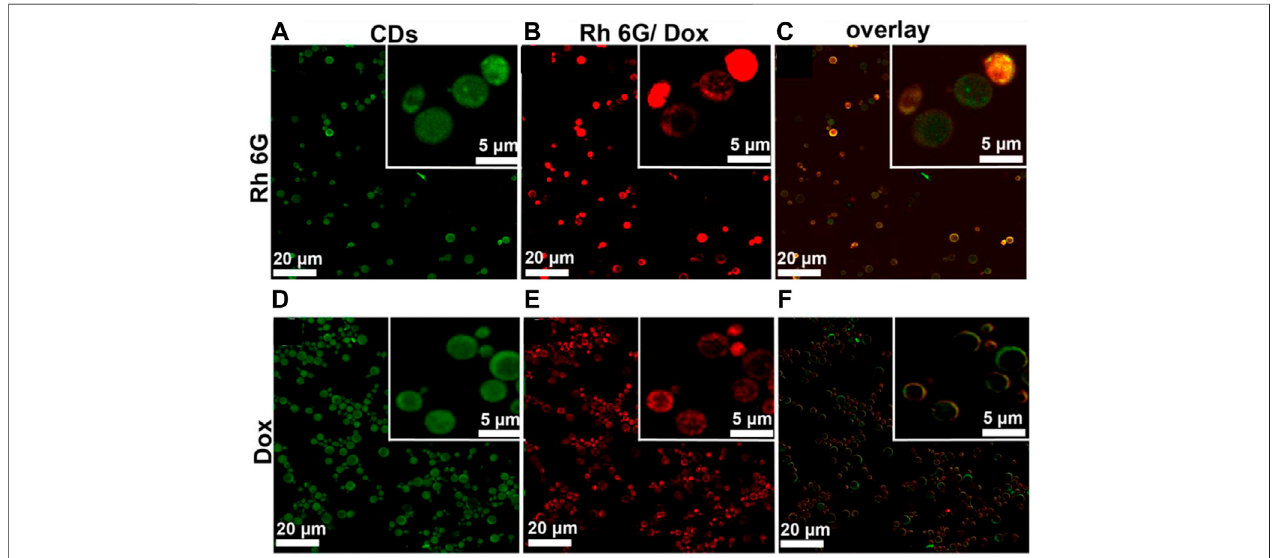
Frontiers in Bioengineering and Biotechnology |